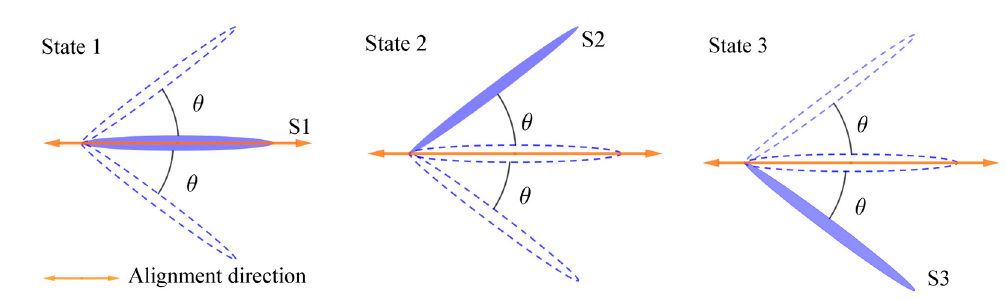
Figure 10. Top view to illustrate the ferroelectric liquid crystal (FLC) molecule orientation. State 1 represents the no-applied-electric-field state, and State 2 and 3 represent the two different states with different electric field polarities.